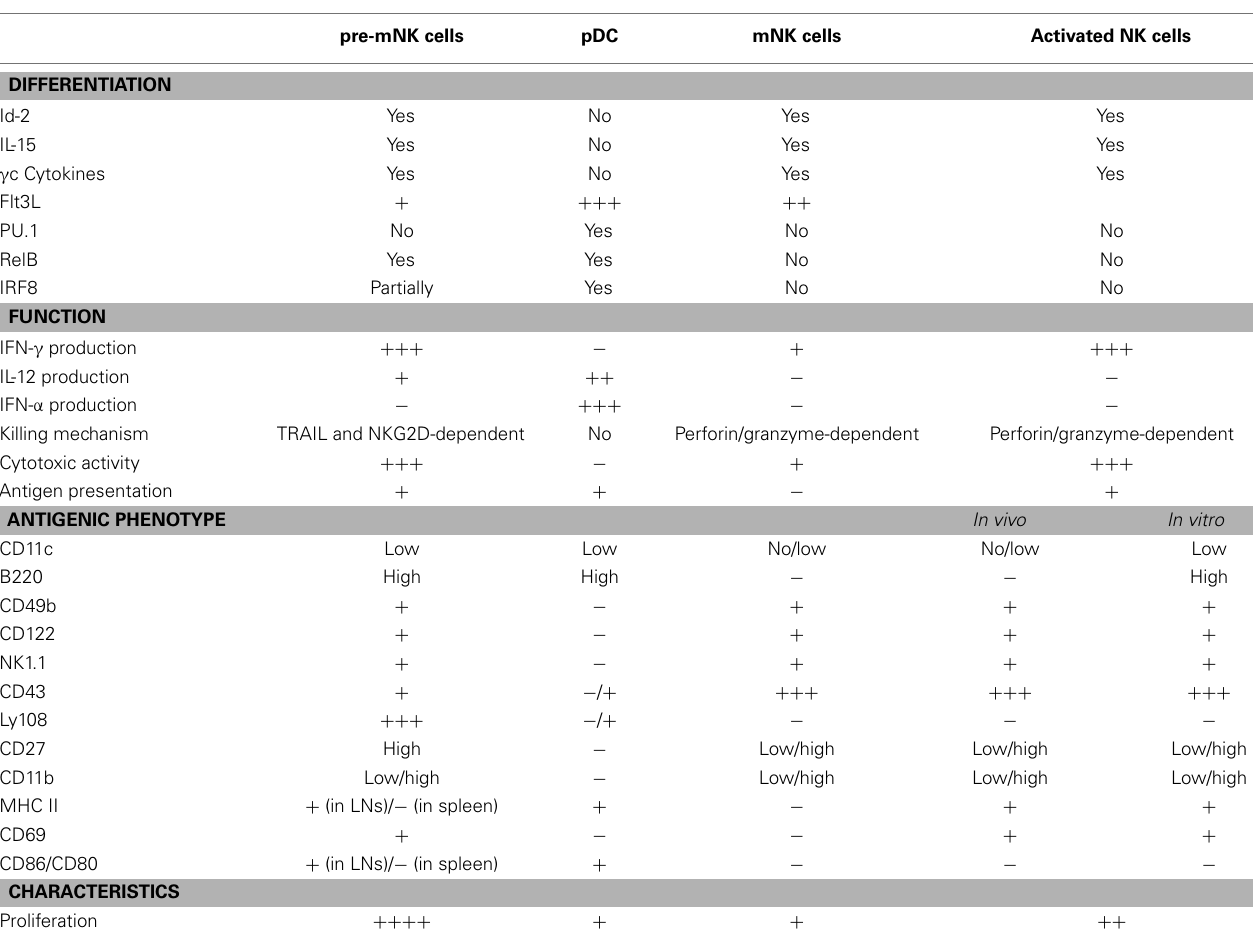
Table 1 | Properties of pre-mNK cells relative to pDC and NK cells. pre-mNK